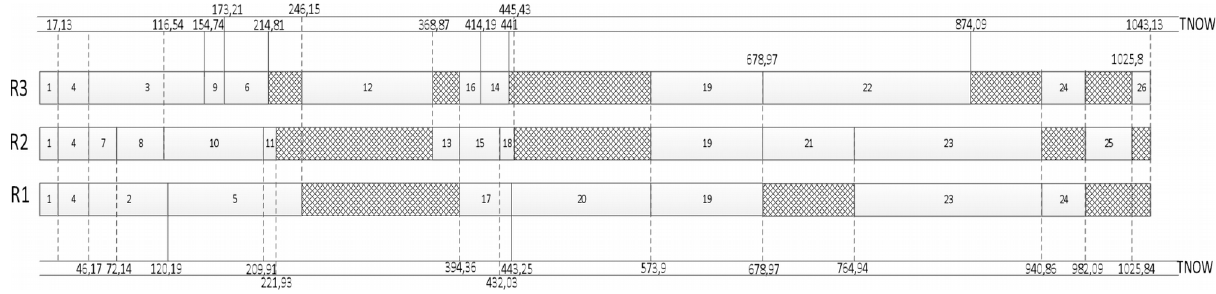
Figure 14. Gantt Chart for the ACTIM, ACTRES, dan TIMRES Scheduling (Scenario